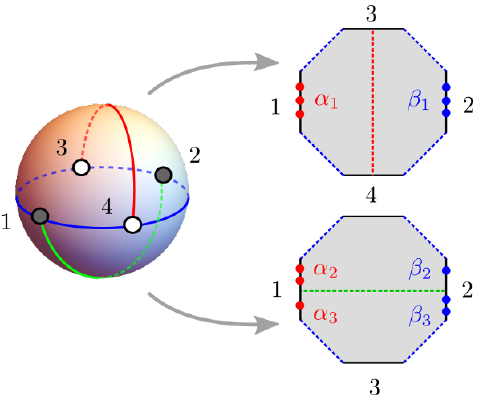
Figure 15 . One possible tessellation of the four-point function. The vertical black arrows denote the direction in which we move the excitations. Originally all the red excitations are in partition (cid:11) 1 , and then we move them downwards by inserting suitable twists in front of the hexagon form factors; similarly for the blue excitations on partitions (cid:12) i